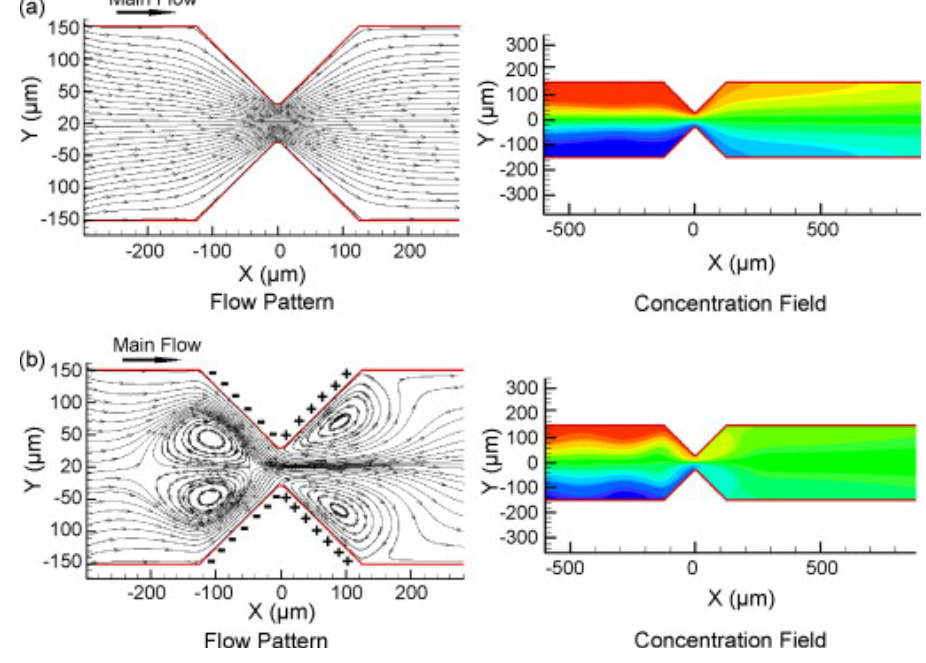
Figure 21. Flow and concentration fields around hurdles made of (a) non-conducting and (b) conducting materials (from Wu and Li